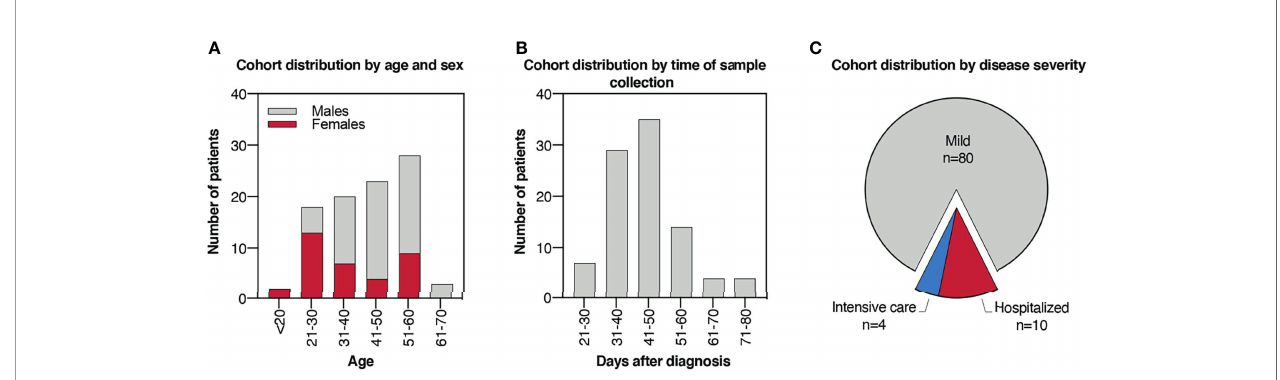
FIGURE 1 | Cohort of COVID-19 convalescent patients. (A) Histogram plot indicating cohort distribution by age expressed in years and sex. (B) Histogram plot indicating cohort distribution by time of sample collection expressed as days after PCR - con fi rmed COVID-19 diagnosis. (C) Pie chart indicating cohort distribution by disease severity. Patients who did not require hospitalization were de fi ned as “ mild ” cases, while hospitalized patients were de fi ned as “ severe ” cases. Among the severe cases, patients who underwent intensive care